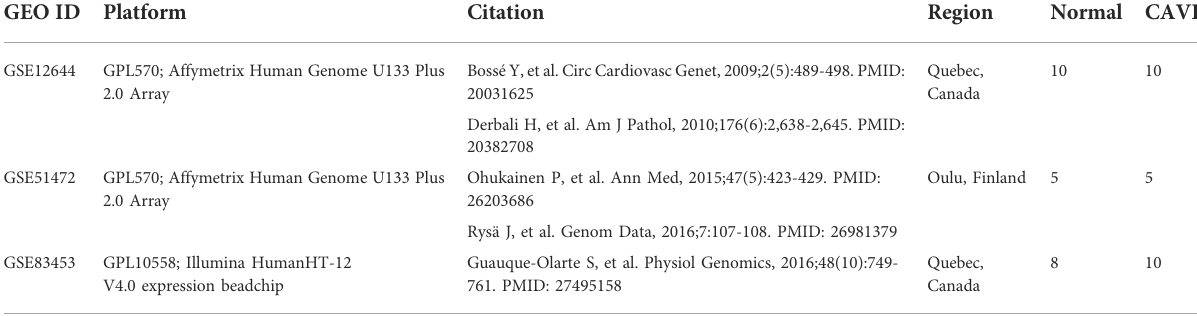
TABLE 1 Characteristics of the datasets included in the integrated